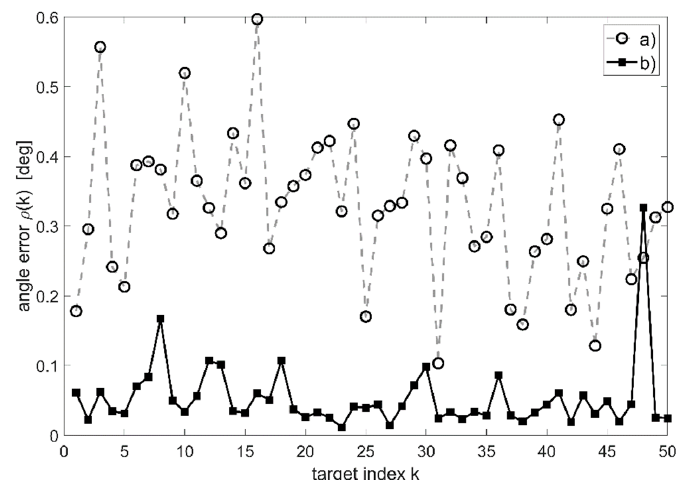
Figure 8. Target orientation error calculated from data acquired in Experiment 1 with the laser tracker: ( a ) uncorrected error ρ unc ; ( b ) corrected error ρ cor .